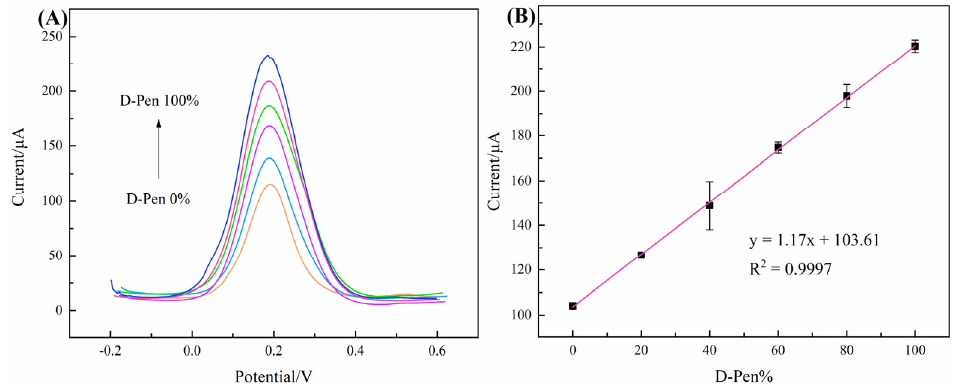
Figure 11. ( A ) DPV of 5 mM Pen enantiomeric mixed solution containing different contents of D-Pen (0%, 20%, 40%, 60%, 80%, and 100%) with PAA-MWCNTs-Ag-SCS/GCE; ( B ) Linear relationship between Ip and D-Pen% in the enantio-enriched solution.